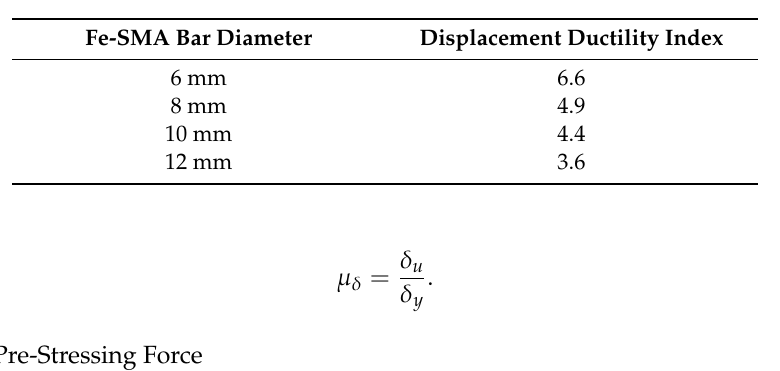
Table 1. Values of µ δ for Beam 10 pre-stressed by di ff erent diameters of Fe-SMA bar.